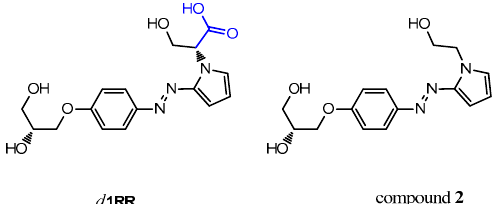
Figure 10. Chemical structure of d 1RR and of the synthesized decarboxylate derivative, named compound 2 .